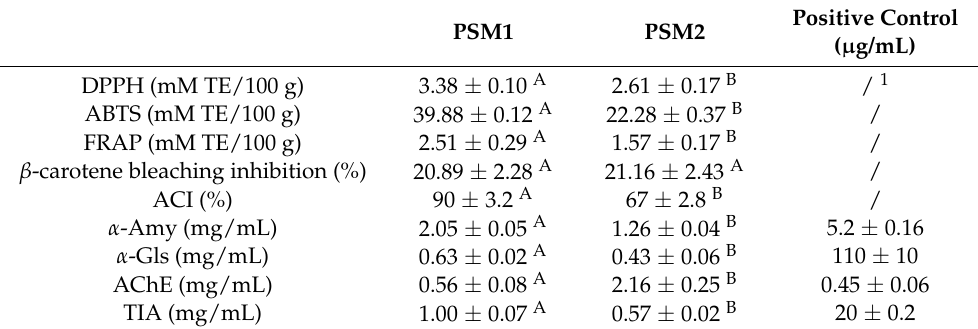
Table 3. Antioxidant activities and enzyme inhibitory effects (IC 50 ) of blackthorn fruit methanol